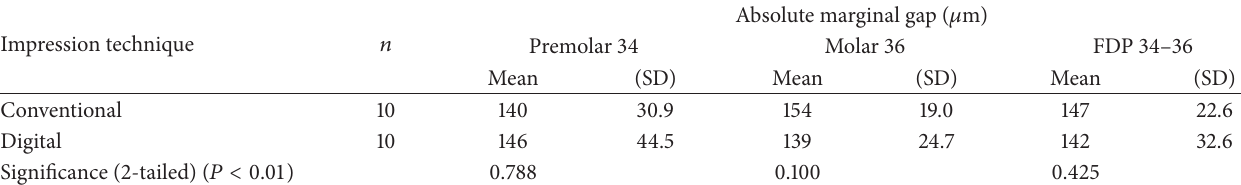
Table 2: Absolute marginal gap between finish line and crown margin for conventional and digital impression techniques.